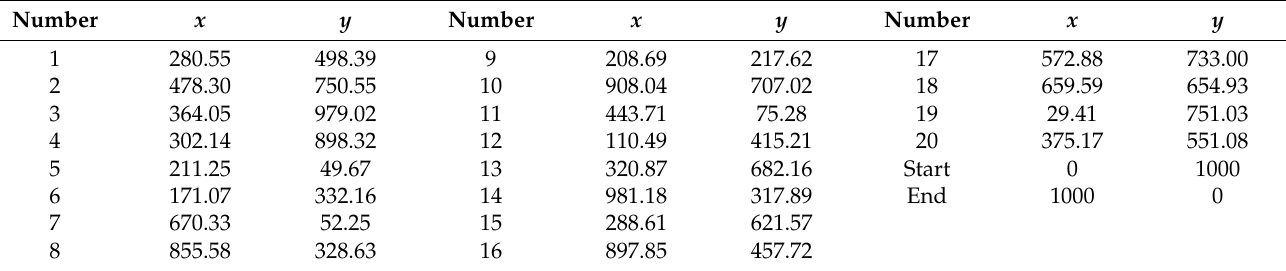
Table A1. Coordinates of the target points